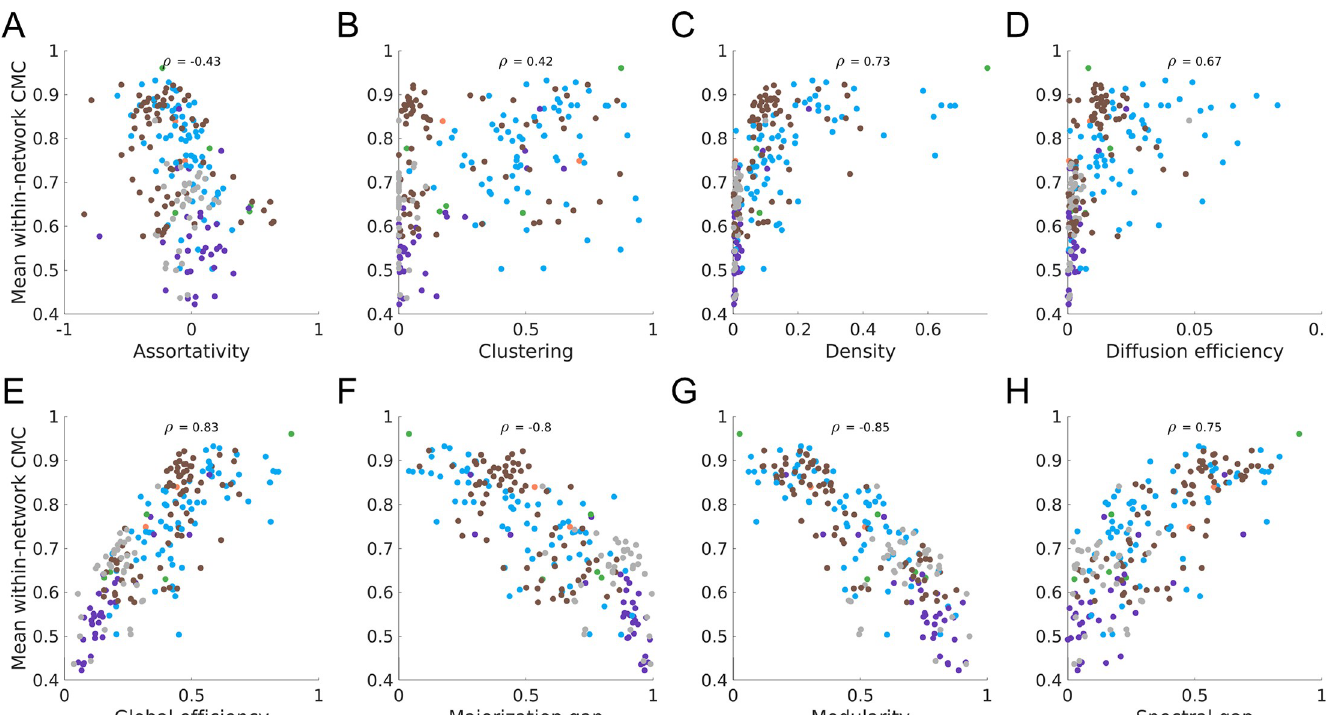
Fig 4. Association between mean within-network CMC and network properties in unweighted networks. The association between the mean within-network CMC (the average of all CMCs within a single network) and each of the global topological properties. Networks are coloured by their natural category (blue = social, grey = technological, brown = biological, orange = informational, purple = transportation; green = economic).